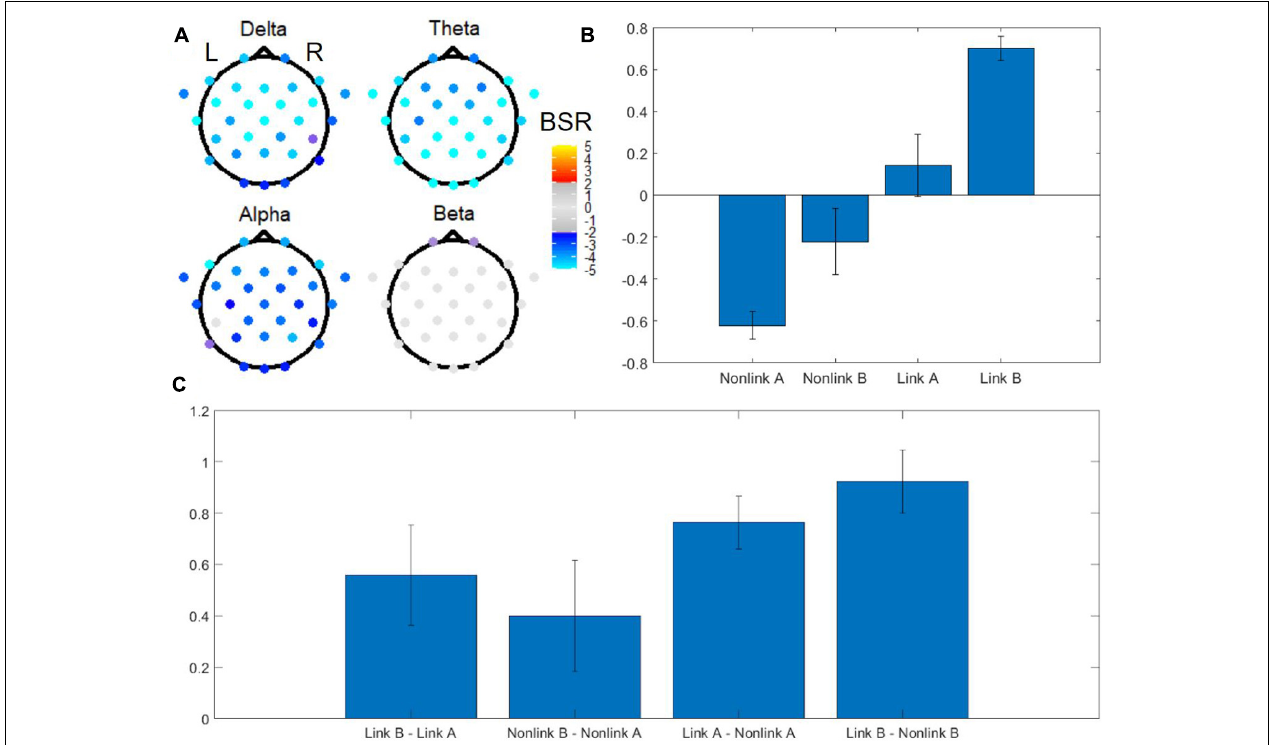
FIGURE 5 | Omnibus task PLS analysis of EEG power for TMT performance. (A) BSRs of EEG scalp electrodes in the delta, theta, alpha and beta bands (first latent variable). Significant BSRs are shown according to the color scale given, after correction for multiple comparisons using the false discovery rate (FDR) at q = 0.05 and an additional threshold of |BSR| > 2 to remove results that were unstable during the resampling procedure. The spatial pattern for the gamma band is not shown due to lack of statistical significance. (B) Mean loadings of task condition weights. Error bars indicate standard deviations. (C) Mean loadings of task contrast weights. Error bars indicate standard deviations. L = left, R = right, BSR = bootstrap ratio, Link A = linking period of TMT-A, Link B = linking period of TMT-B, Non-link A = non-linking period of TMT-A, Non-link B = non-linking period of